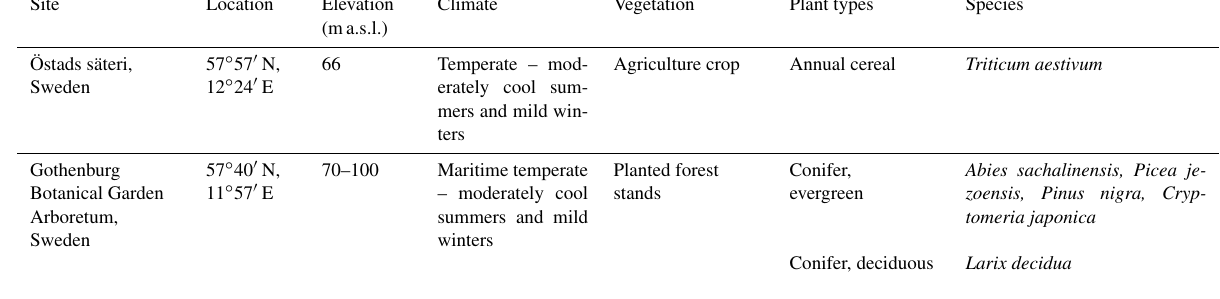
Table 1. Location, elevation and climate of the study sites as well as the plant types and species sampled.